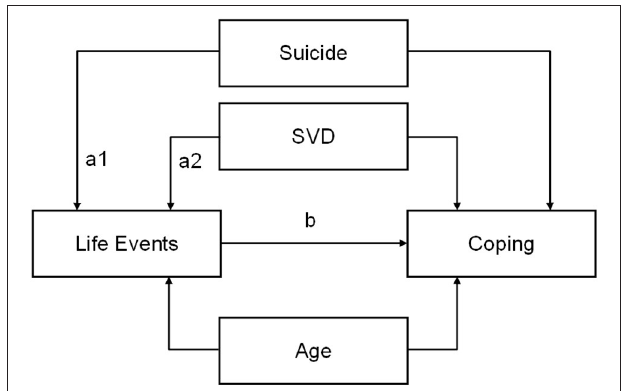
FIGURE 1 | Illustration of the conducted mediation analyses with the control group as reference. For suicide vs. control the size of the indirect/mediated effect equals a1 × b and for sudden violent death (SVD) vs. control a2 ×